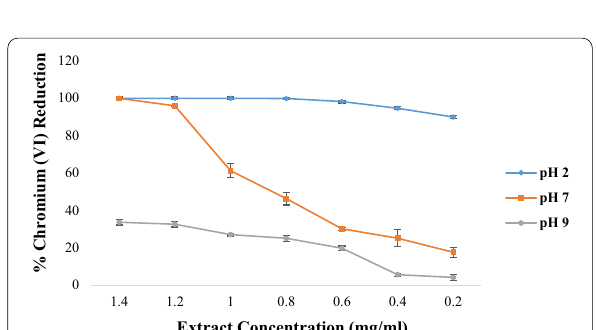
Fig. 2 Effect of initial extract concentration on hexavalent chromium reduction by Tamarindus indica methanol leaves extract. (Chromium concentration 10 mg/L, temperature = pH 2.0, 7.0 and =